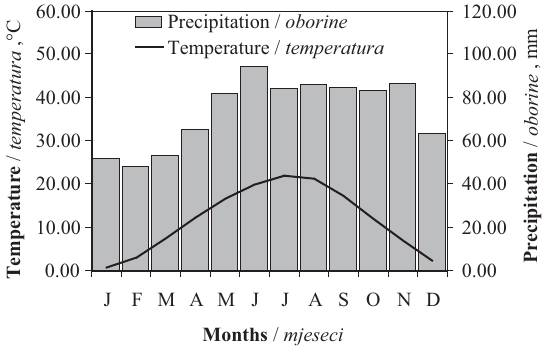
Figure 1 Bagnouls Gaussen Climatic Diagram, mean monthly average temperature (line) and mean monthly sum of precipitation (bars), of meteorological station Grič, Zagreb for the period 1922-2009; the mean annual precipitation is 879 mm and the mean annual temperature is 11.76 ºC Slika 1 . Dijagram klime, prosječne mjesečne temperature (linija) i prosječnog zbroja mjesečnih oborina (stupići) u meteorološkoj postaji Grič, Zagreb, za razdoblje 1922. – 2009.; prosjek godišnjih oborina iznosi 879 mm, a prosjek godišnje temperature 11,76